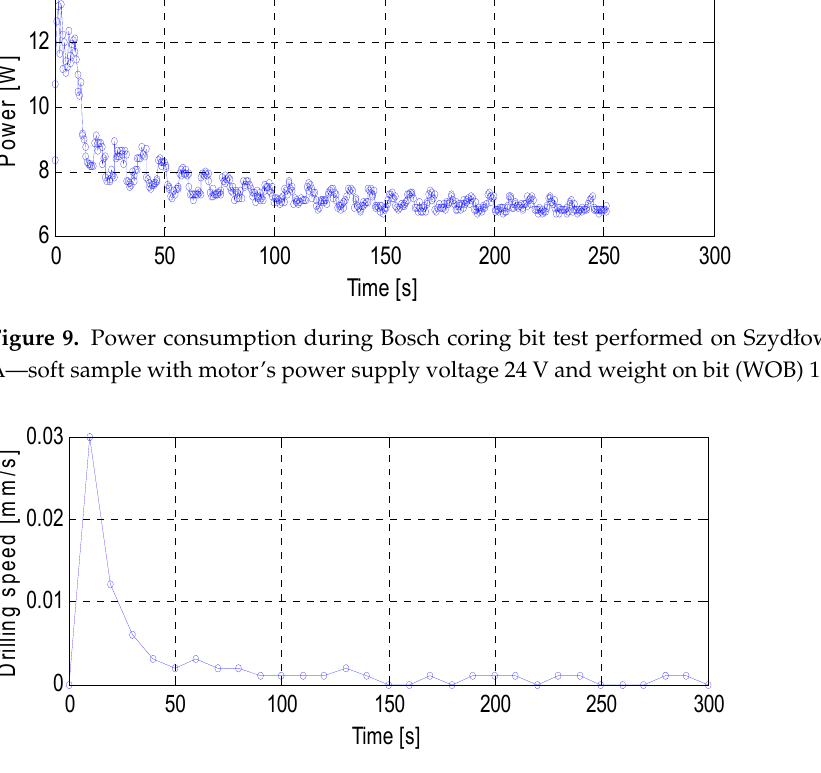
Figure 10. Drilling speed during Bosch coring bit test performed on Szydlowiec sandstone A—soft sample with motor’s power supply voltage 24 V and weight on bit (WOB) 105.75 N.